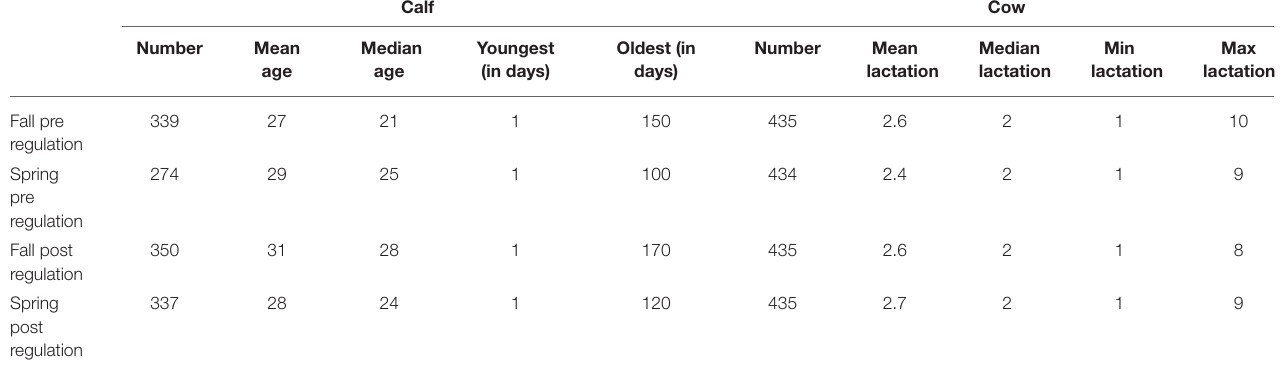
TABLE 2 | Descriptive statistics of cattle sampled in 87 farms dairy farms in Québec, Canada, per period of sampling (pre and post regulation). Calf